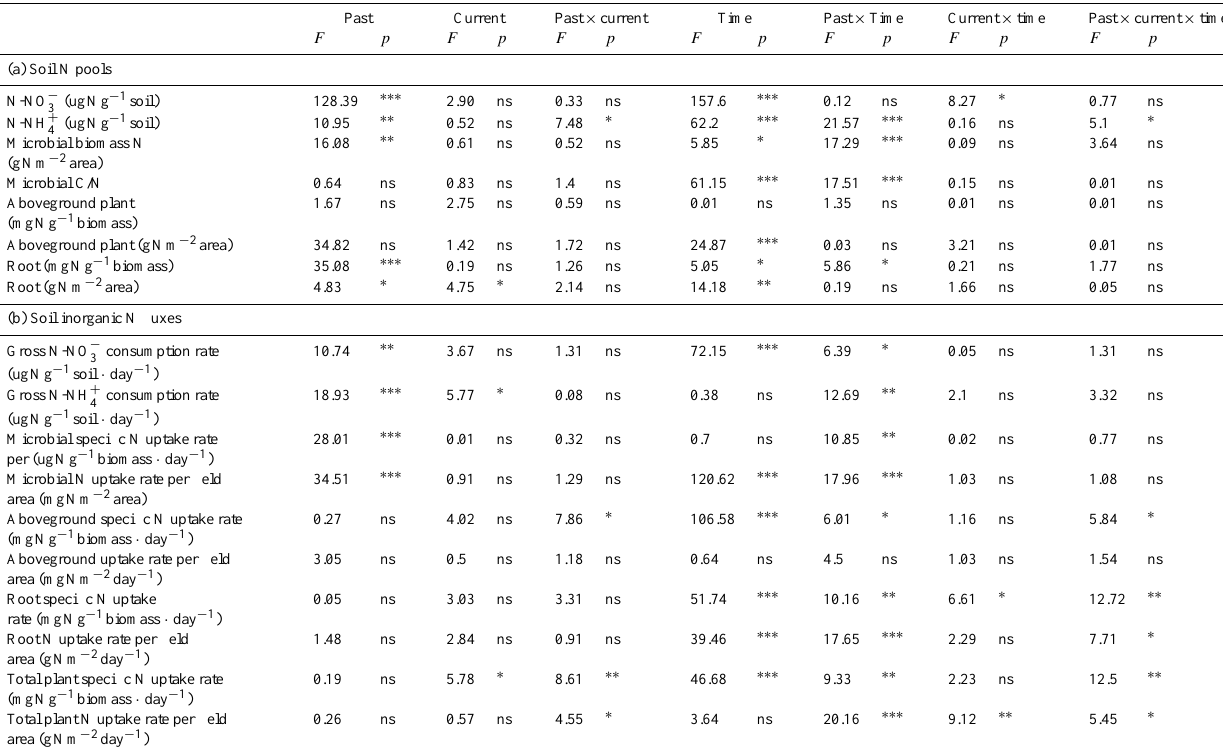
Table 2. Effect of sampling “time” (end of snowmelt 2010 vs. peak biomass 2005), and interaction with past (terraced vs. unterraced) and current (mown vs. unmown) land uses on N pools and fluxes of soil, plant and microbial communities. Values are results of ANOVAs ( F ) and significance ( ∗∗∗ p < 0 . 001, ∗∗ p < 0 . 01, ∗ p < 0 . 05, ns: not